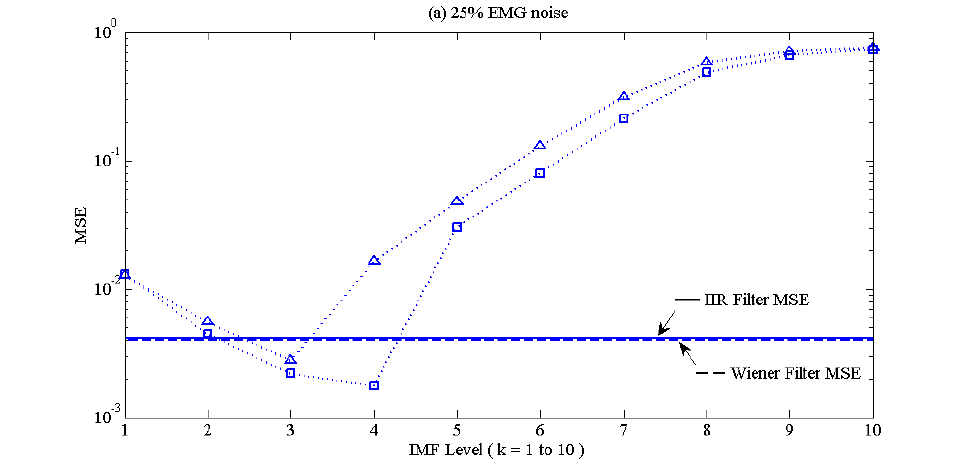
Figure 6. MSE distribution of ventricular arrhythmia ECG (V1) with (a) 25% EMG noise , (b) 100% baseline wander for EMD (dot line with triangle mark), EEMD (dot line with square mark),on different IMF levels. Corresponding MSE of Wiener filter (dash line) and IIR filter (solid line) with low pass filter spec are also shown in (a) and in (b) with high pass filter spec. The minimum MSE of EMG noise is at k = 3 for EMD and k = 4 for EEMD, and minimum MSE of baseline wander is at q = 8 (EEMD) and q = 4 (EMD),